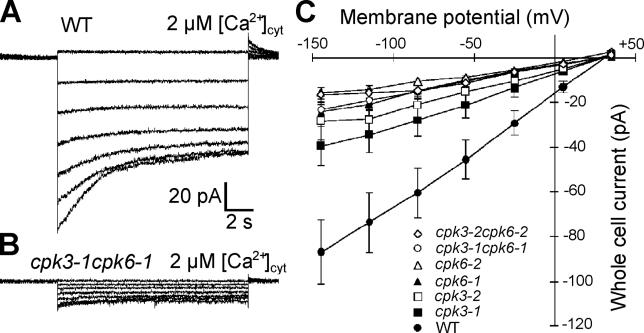
Impairment in [Ca2+]cyt-Dependent Activation of S-Type Anion Channel Currents in Guard Cells of cpk3 and cpk6 Single and cpk3cpk6 Double Mutants(A and B) Typical S-type anion channel current traces in wild-type (WT) (A) and cpk3-1cpk6–1 double mutant (B) guard cells are shown in response to 2 μM free Ca2+ in the patch-clamp pipette solution that dialyzes the cytoplasm.(C) Average current-voltage curves of wild-type (n = 17 cells), cpk3–1 (n = 11), cpk3–2 (n = 7), cpk6–1 (n = 11), cpk6–2 (n = 4), cpk3-1cpk6–1 (n = 17), and cpk3-2cpk6–2 (n = 11). Error bars show SEM.